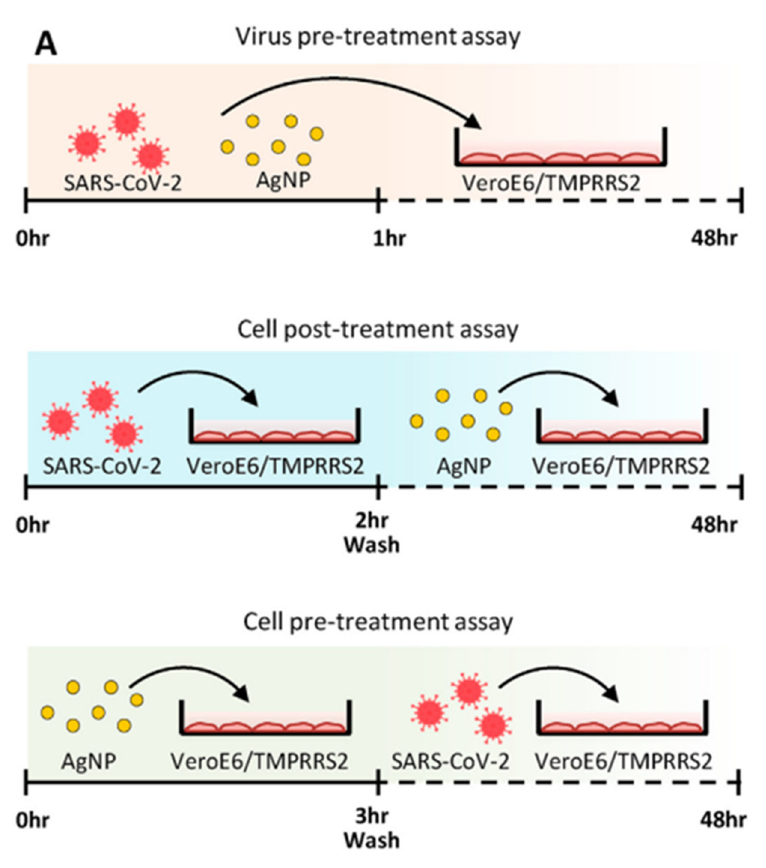
Figure 8. Action of AgNPs on SARS-CoV-2 virus. Reprinted with permission from Elsevier [115]. 2022, Karthik V Shankar.